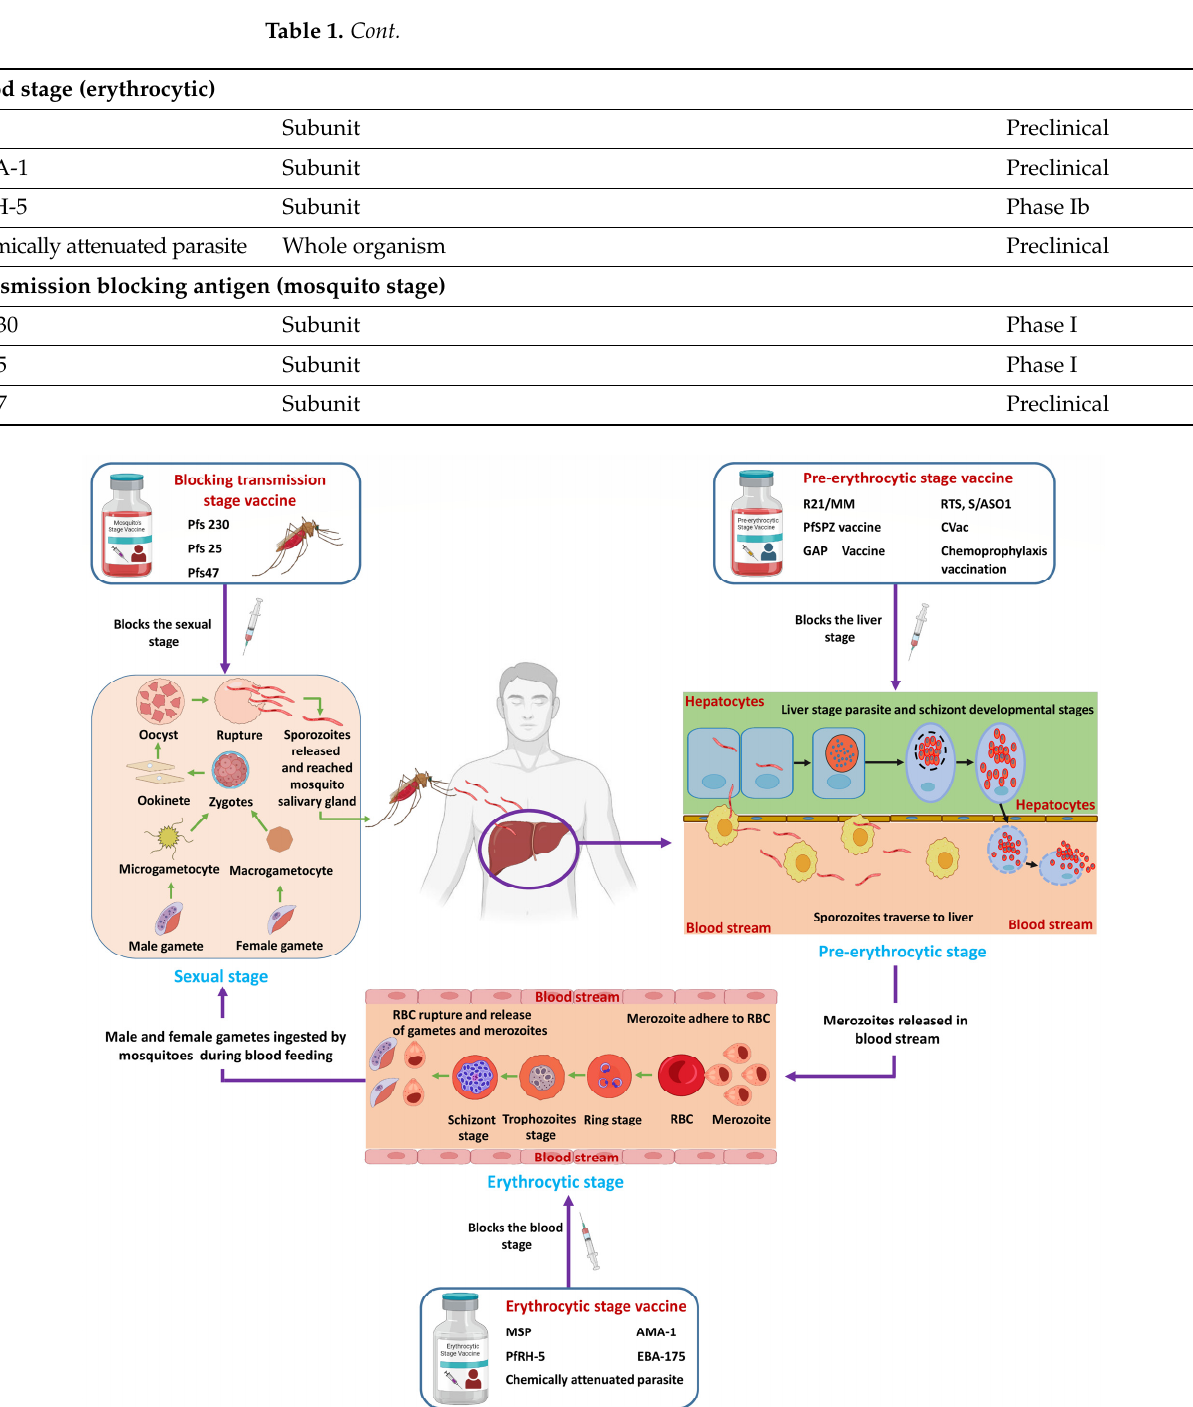
Figure 1. Human malaria vaccines: current state and developments at different stages. Pfs230 ( Plasmodium falciparum Pfs230 protein); Pfs25 ( Plasmodium falciparum Pfs25 protein); Pfs47 ( Plasmodium falciparum Pfs47 protein); R21/MM (R21/Matrix-M™ vaccine); RTS’S/AS01 (repeated T-epitopes derived from PfCSP and S-antigen derived from hepatitis B surface antigen and the AS01 adjuvant); PfSPZ ( Plasmodium falciparum sporozoite); CVac (chemically modified vaccine); GAP (genetically attenuated parasite); RBC (red blood cell); MSP (merozoite surface protein); AMA-1 (apical mem- brane antigen 1); PfRH-5 ( Plasmodium falciparum reticulocyte-binding protein homolog 5); EBA-175 (erythrocyte-binding antigen 175).